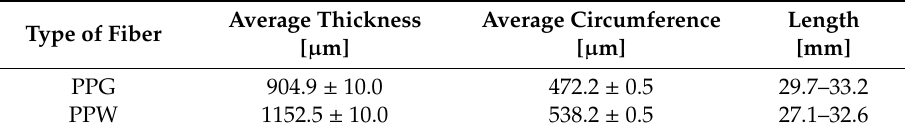
Table 4. Properties of the green (PPG) and white polypropylene fibers (PPW) (own research). Type of Fiber